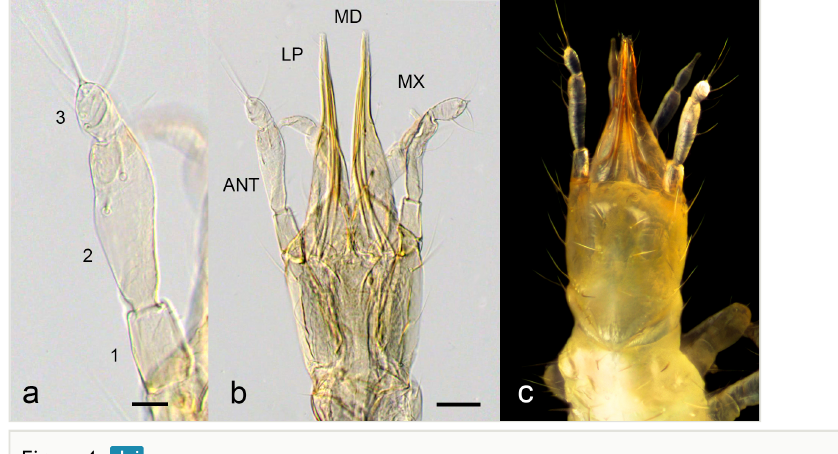
Figure 4. Larval head of Ditaxis biseriata . a and b. Cleared whole-mount of fi rst instar larval antenna (a) and head (b). The antennal segments are numbered from proximal to distal. The head structures depicted in (b) include the antennae (ANT), labial palps (LP), mandibles (MD) and maxillae (MX). c. Dorsal view of the head of a preserved fi rst instar larva. Scale bar in (a) is 20 microns and in (b) 50